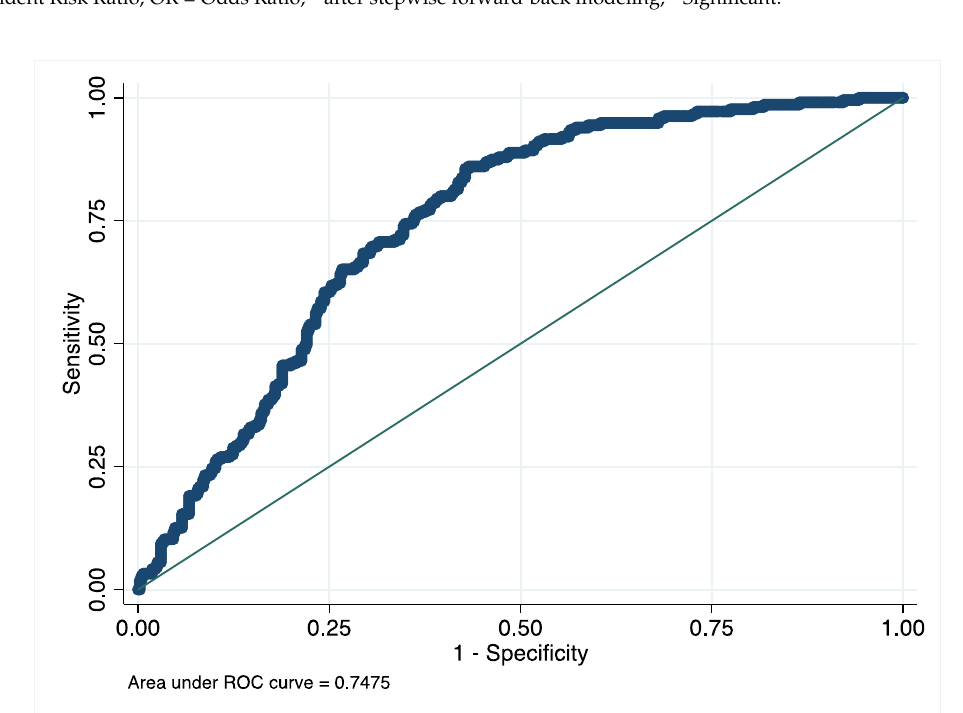
Table 5. Cut-off values.